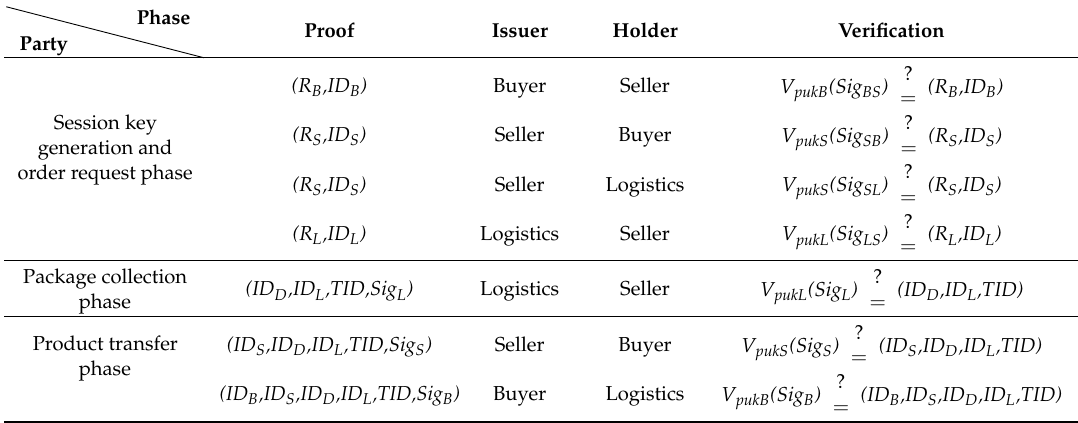
Table 1. Non-repudiation of the proposed